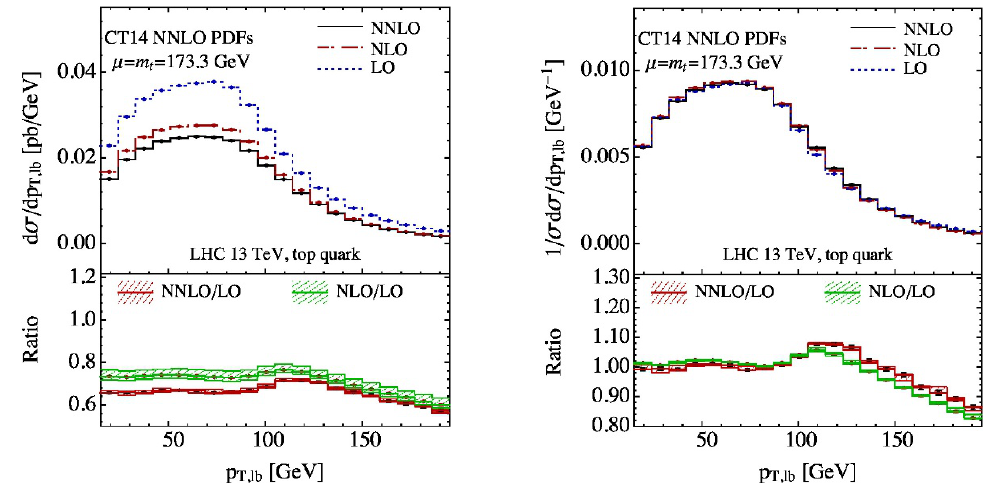
Figure 27 . Predicted transverse momentum distribution of the charged lepton and b -jet system from t -channel single top-quark production at 13 TeV after (cid:12)ducial cuts, with full corrections in- cluded, with and without normalization respectively.